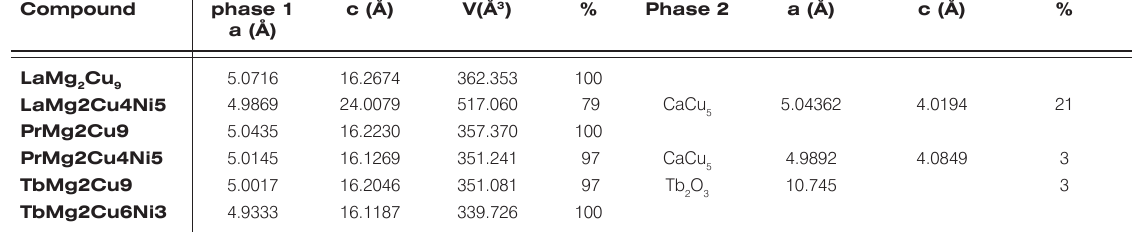
Table 4. Analysis of the powder x-ray diffraction patterns.